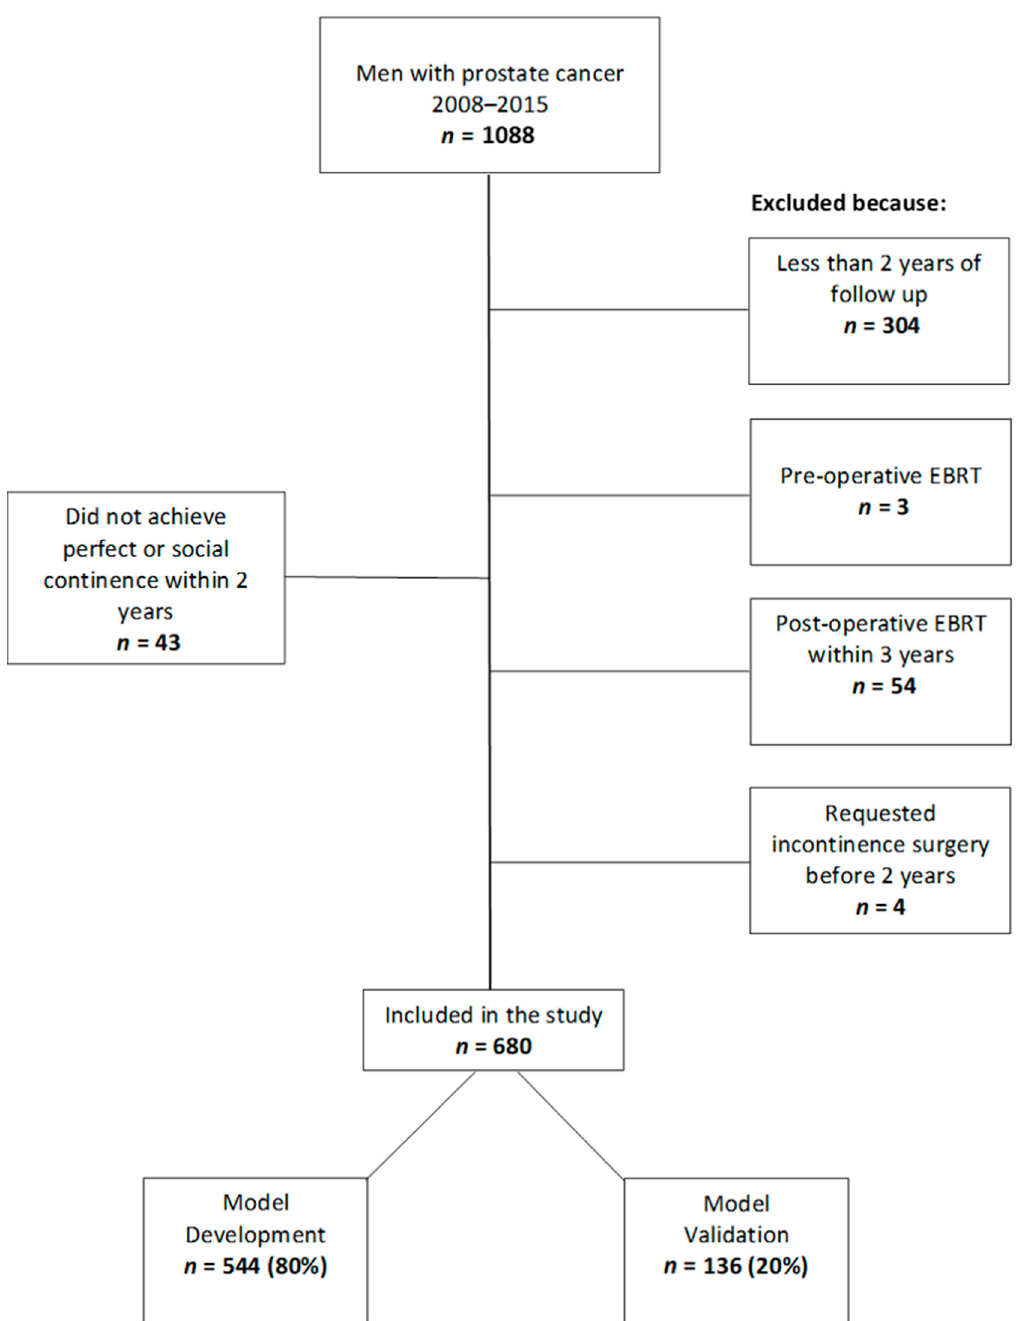
Figure 1. Flow diagram of patients excluded from the study and distribution of remaining patients into model development and validation cohorts; EBRT = external beam radiotherapy.